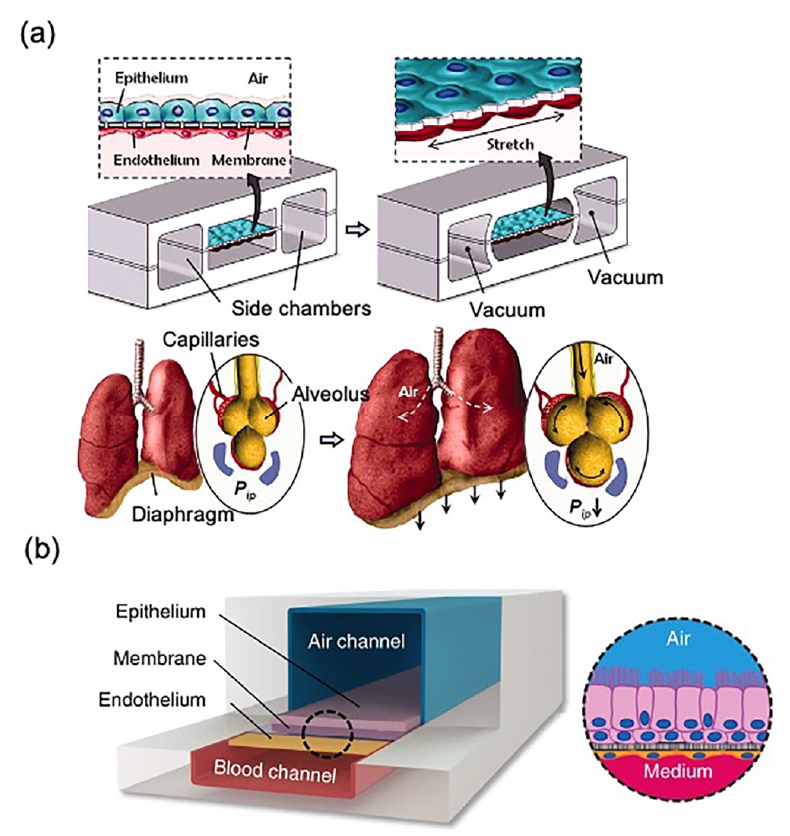
Figure 2. Design of two classical human breathing LOC microdevices: ( a ) Schematic diagram of “alveolar lung-on-a-chip”; physiological breathing movements were reproduced by applying vacuum to the chambers; reproduced with permission from [12]. ( b ) Schematic diagram of the “small airway lung-on-a-chip”; reproduced with permission from [42]. Table 1. Literature review of some biosensor-free LOCs. Chip models, structure of ACI, corresponding remarks, and whether respiration movement was observed are listed in the table for comparison. Chip